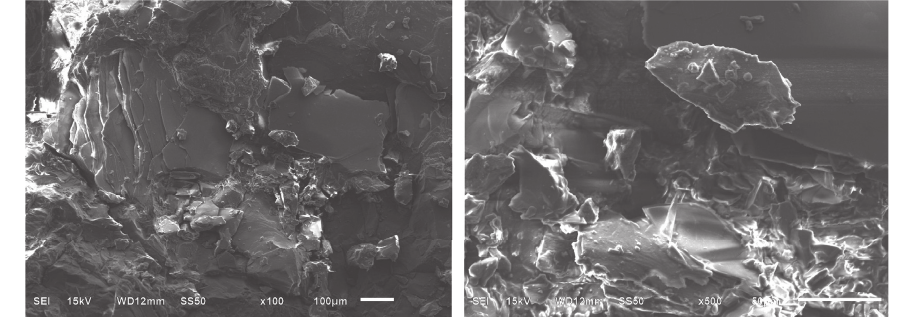
Figure 6: Microscopic damage mode of